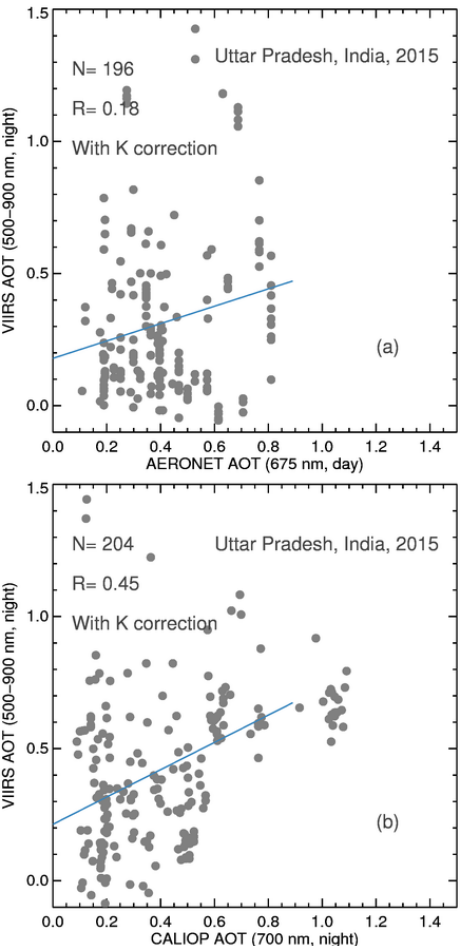
Figure 9. (a) Scatterplot of VIIRS nighttime AOT versus adjacent daytime AERONET AOT (0.675µm) over the state of Uttar Pradesh in India for 2015. Diffuse correction is applied. Panel (b) is similar to (a) but for nighttime CALIOP AOT